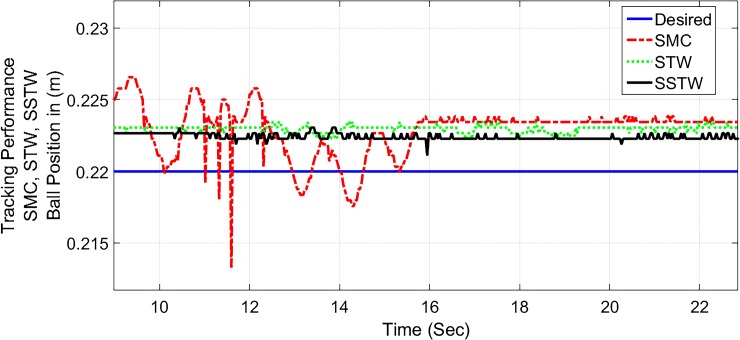
Chattering suppression and output tracking performance of SMC, STW and SSTW, rd = 22cm.